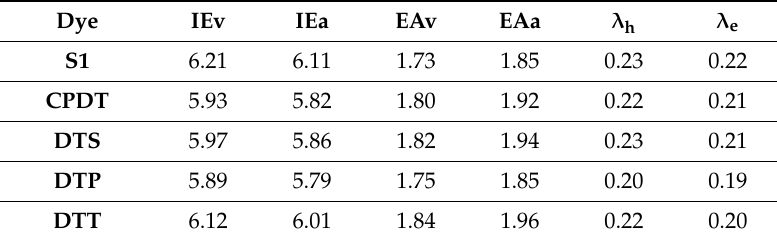
Table 4. Calculated chemical reactivities, vertical electron a ffi nity (EAv) and vertical ionization energy (IEv), along with the adiabatic ones; hole and electron reorganization energy ( λ h , λ e ) of the compounds studied (in eV, B3LYP / 6 − 311G (d,